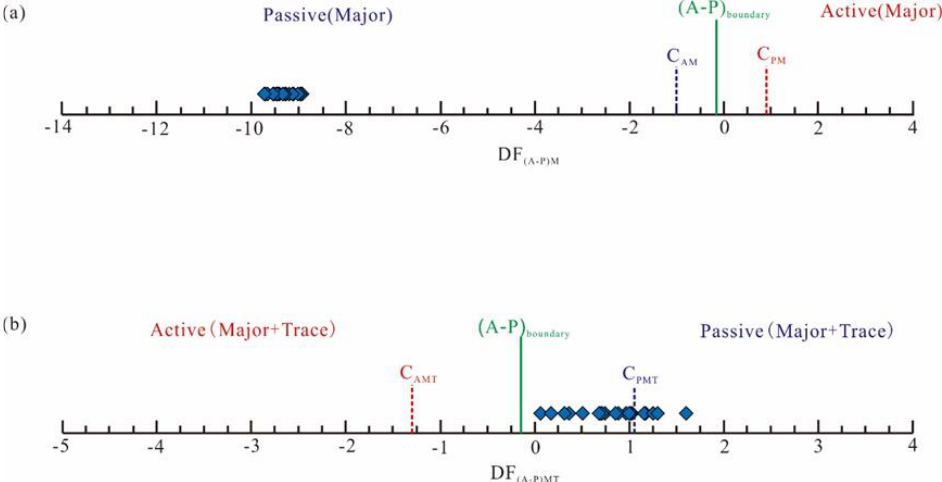
Figure 14. Tectonic setting discrimination of the Zhiluo Formation sandstones [41]. ( a ) ilr based on major elements; (b) ilr based on major elements and some trace elements. DF (A-P)M = (3.0005 × ilr1TiM) ilr1TiM) + (2.8243 × ilr2AlM) + ( − 1.596 × ilr3FeM) + ( − 0.7056 × ilr4MnM) + ( − 0.3044 ×